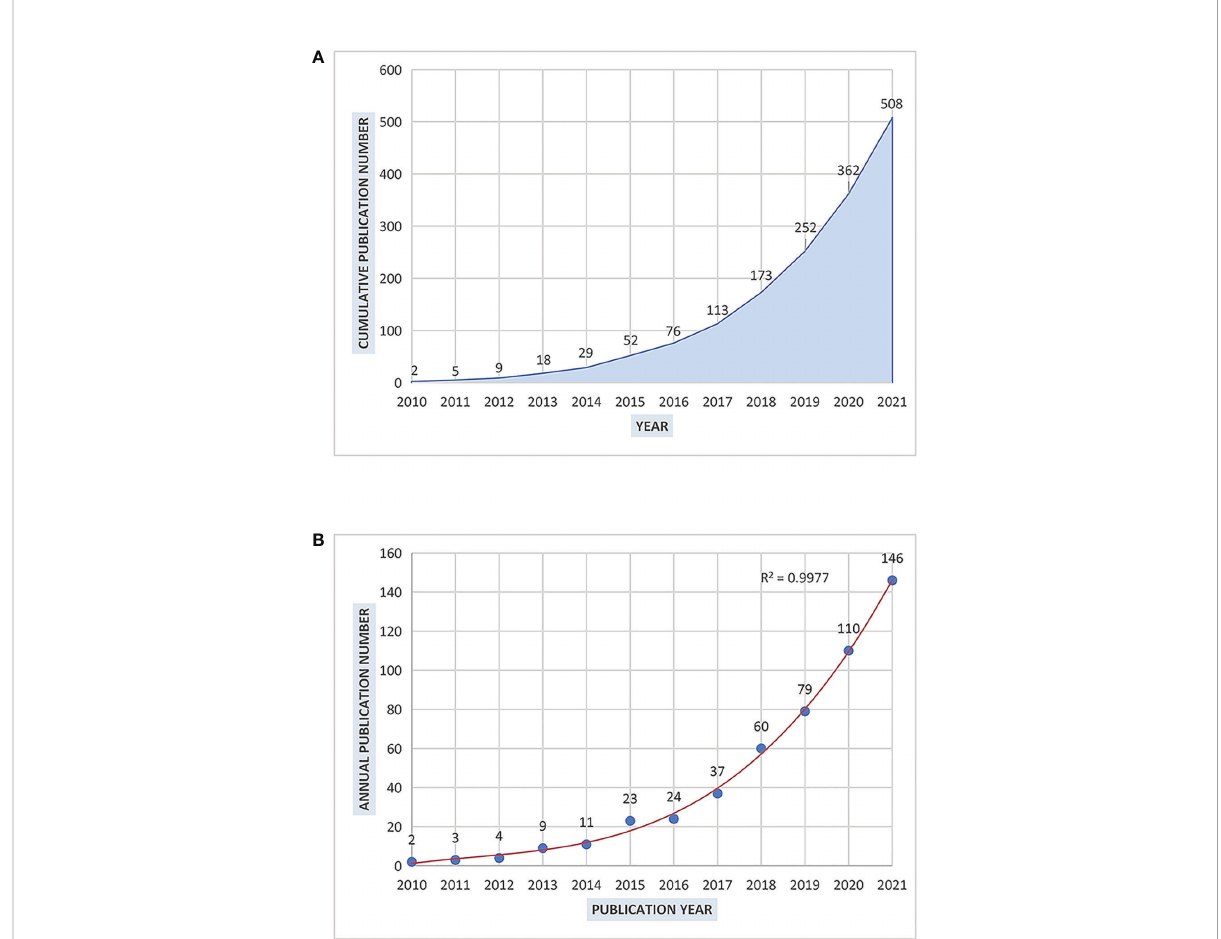
FIGURE 2 The increasing tendency of the number of literatures about NLRP3 in ALI/ARDS. (A) The cumulative number of publications from 2010 to 2021. (B) The annual number of publications from 2010 to 2021 and the polynomial fi tting curve (R 2 = 0.9977).